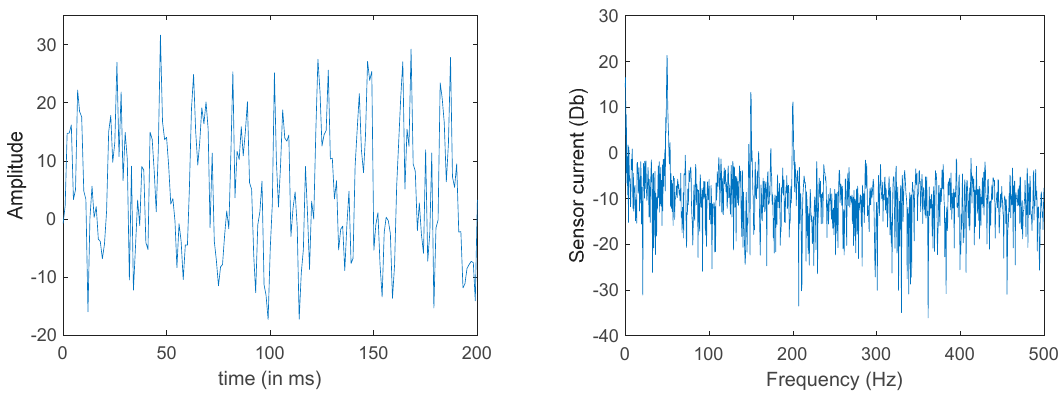
Figure 8. Input signal ( left ) and output signal ( right ) of the signal processing.